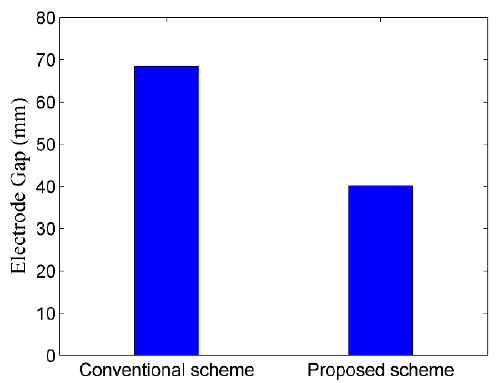
Figure 17. Electrode gap comparison between conventional and proposed GIL schemes.